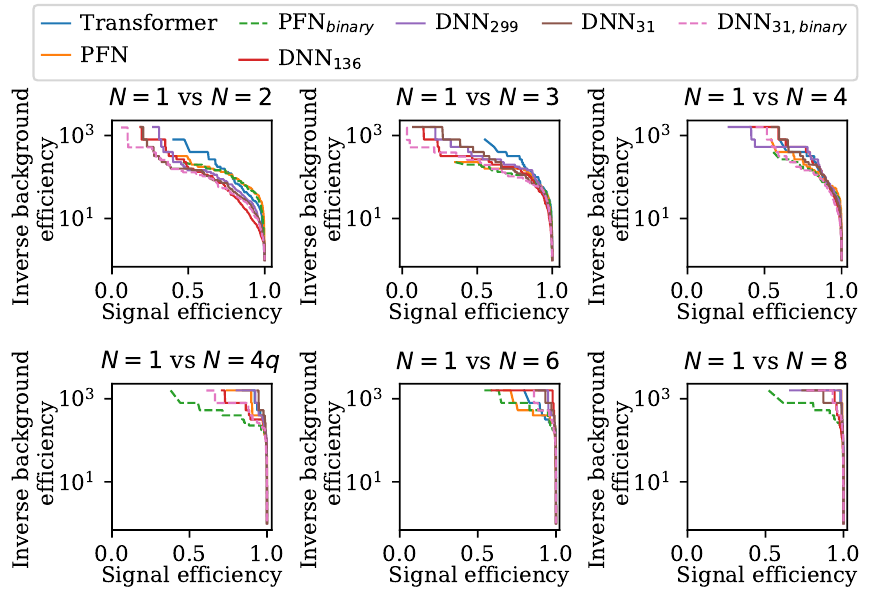
Figure 18 . ROC curves of the various network studies classifying jets with N = k versus N = 1 hard sub-jets. See table 3 for the ROC-AUC percentage